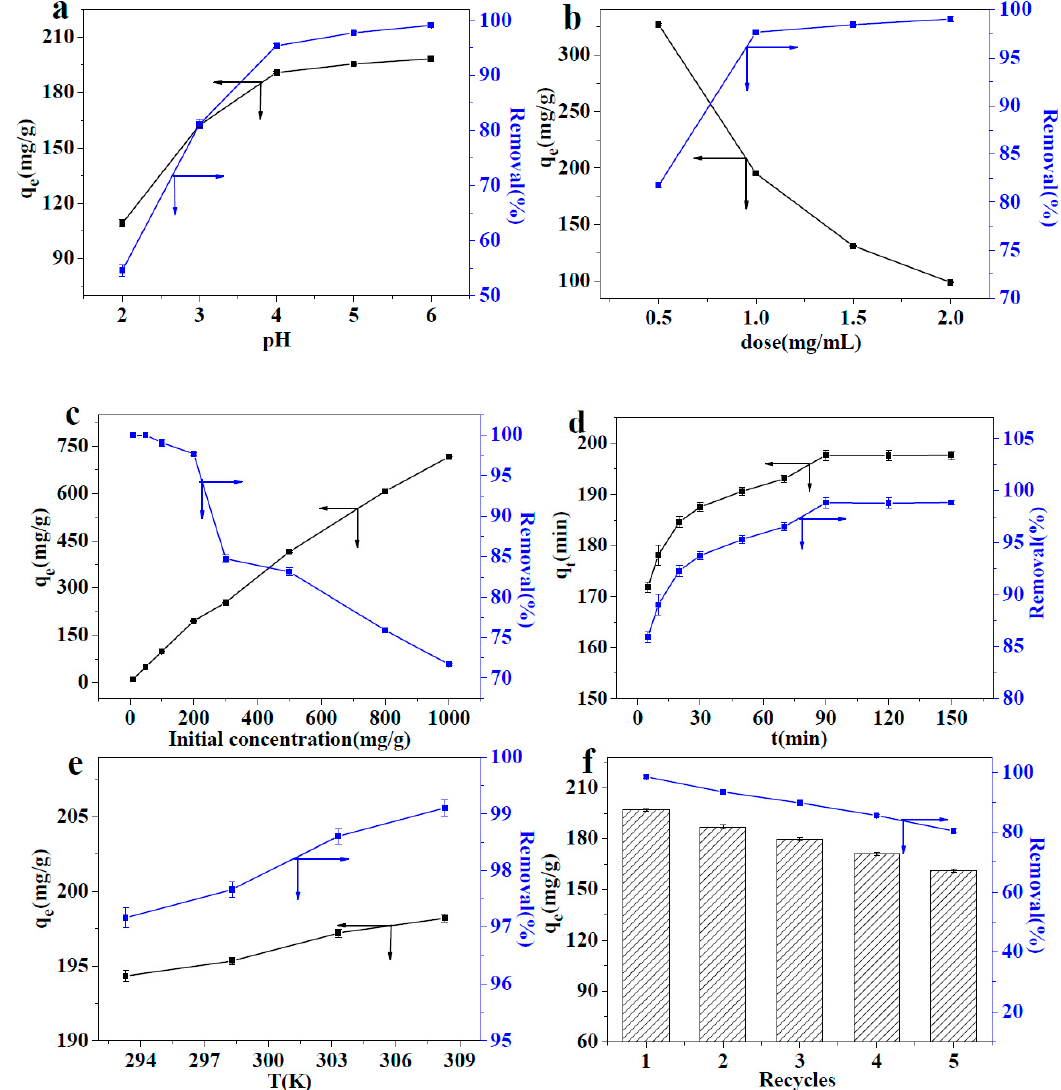
Figure 6. Effects of ( a ) pH, ( b ) adsorbent dosage, ( c ) initial concentration of Pb(II), ( d ) adsorption time, ( e ) adsorption temperature, and ( f ) recycling times on the adsorption capacity (left axis, black) and removal ratio (right axis, blue) of Pb(II) by